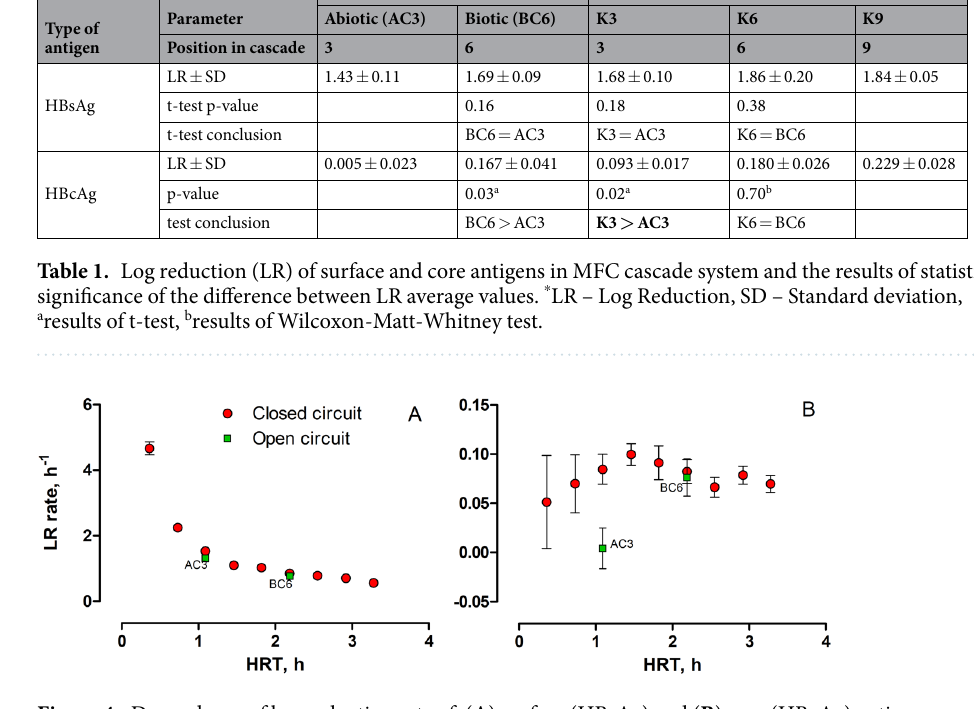
Figure 4. Dependence of log-reduction rate of: ( A ) surface (HBsAg) and ( B ) core (HBcAg) antigen concentrations on hydraulic retention time in open and closed circuit cascades. Data represent average ±